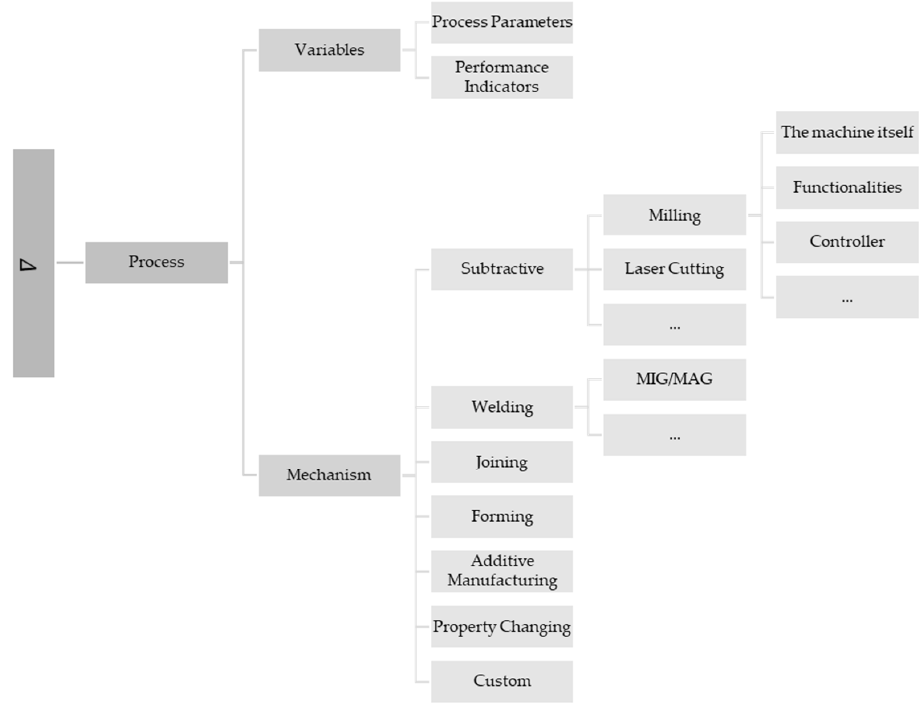
Figure A1. Technologies’ classification: Process-related branch.